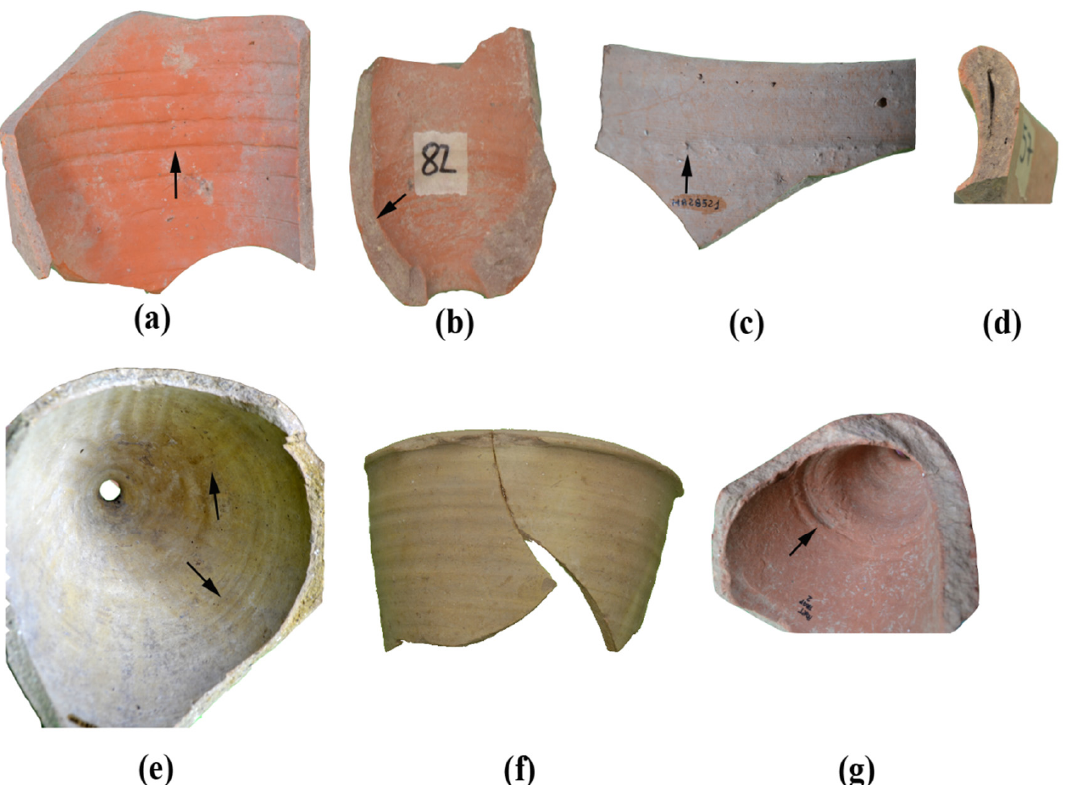
Figure 10. Some examples of the forming macro-traces observed on the sugar cones: ( a ) body of an individual from Himera (not numbered), rings produced by the wheel; ( b ) bottom part of HIM082, change in wall thickness towards the hole; ( c ) inside part of the upper part of HIM172, Y marks; ( d ) section of the rim of HIM057, rolling and folding of the clay outwardly; ( e ) inside bottom part of HIM175, wheel ring, and traces of finger pulling clay towards the hole; ( f ) outside upper part of HIM175 showing wheel rings; ( g ) inside bottom part of PAR005, change in thickness towards the hole, and joint of two sections of the vessel. Arrows indicate points where the features described can be observed. Not to scale.